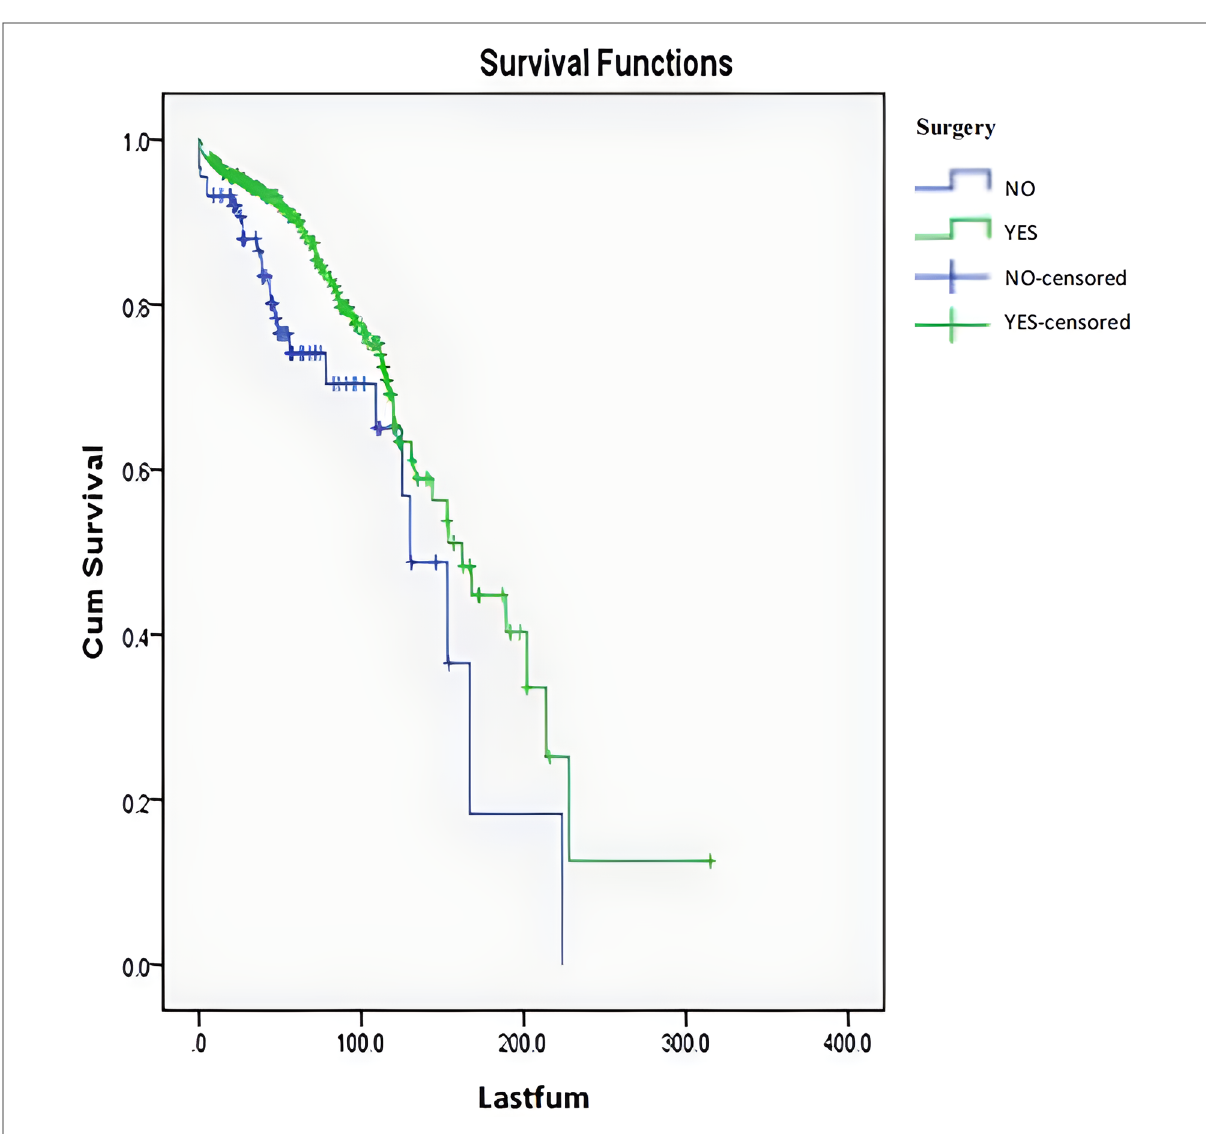
FIGURE 5 Survival curves of the patients with and without